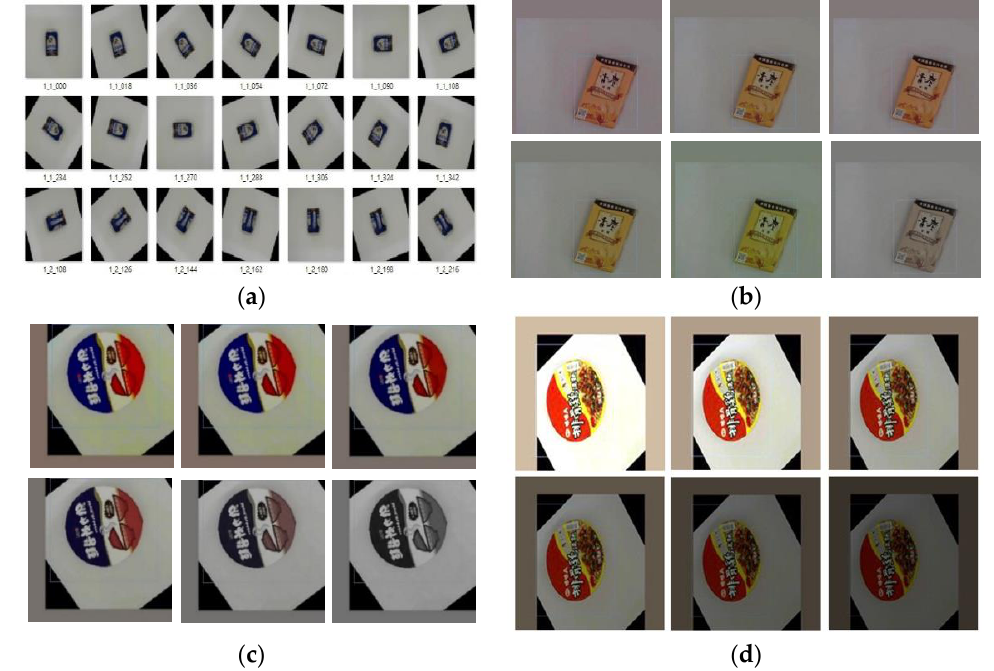
Figure 11. Data augmentation. ( a ) Rotation; ( b ) hue; ( c ) saturation; ( d ) exposure.